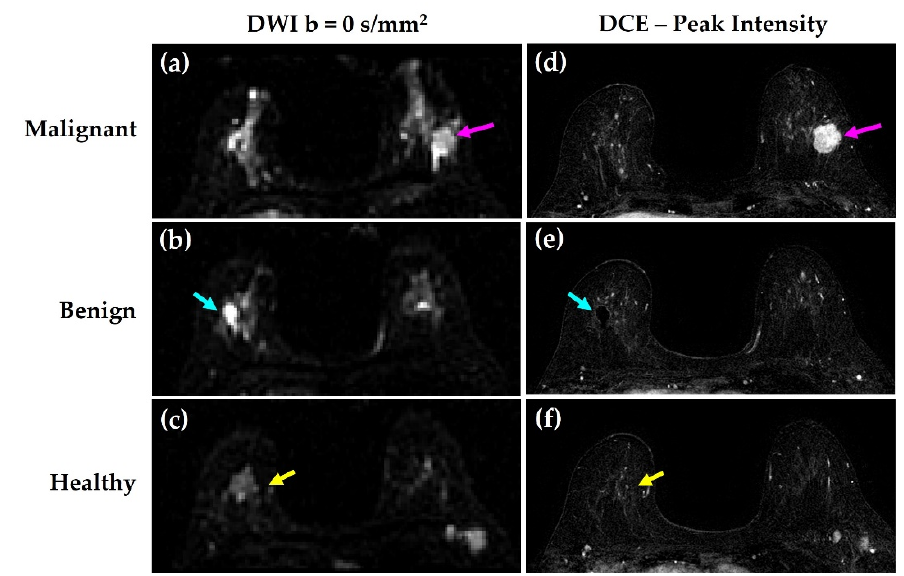
Figure 2. Representative lesions in one patient. Malignant (magenta), benign (cyan), and healthy (yellow) tissues are shown on ( a – c ) DW-MRI b = 0 s/mm 2 and ( d – f ) DCE-MRI peak intensity images. Malignant ROIs were drawn for the lesions corresponding to pathology-proven cancer, and benign ROIs were drawn for those corresponding to pathology-proven benign